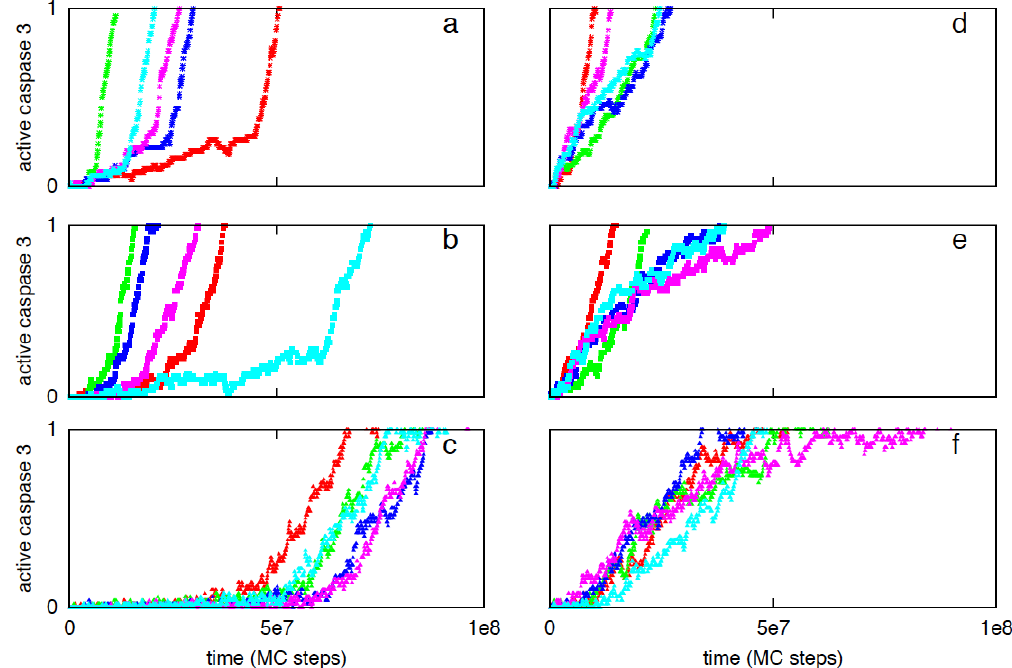
Figure 3. Single cell caspase 3 activation for different values of XIAP to Smac ratio and active caspase 8 levels. Two distinct active caspase 8 concentrations are studied: 1 nM (left panel: a , b , c ) and 10 nM (right panel d , e , f ). The following XIAP and Smac levels are simulated: XIAP = 30 nM, Smac = 50 nM ( a and d ), XIAP = 30 nM, Smac = 10 nM ( b and e ), XIAP = 90 nM, Smac = 50 nM ( c and f ). Data is shown for 5 representative single cells in each of the above cases; each color corresponds to apoptosis activation for a single cell (Monte Carlo